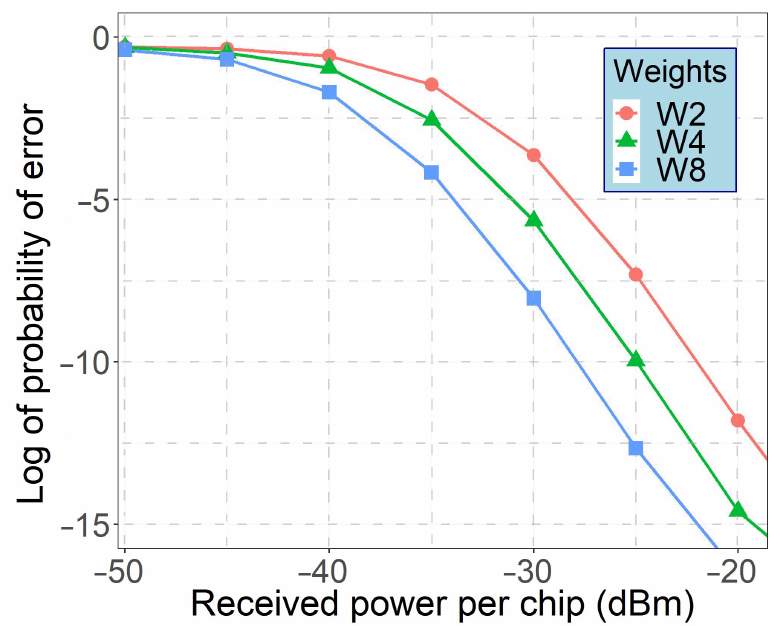
Figure 7. Probability of error versus ROP per code for concurrently transmitting users using code weight W of 2, 4 and 8.